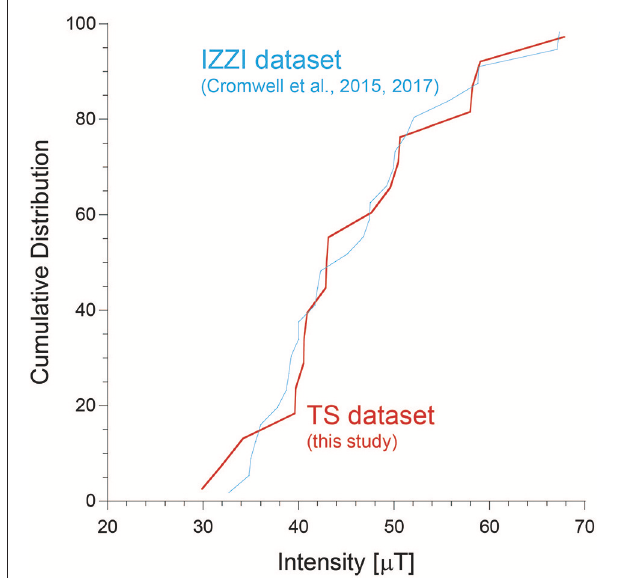
FIGURE 7 | Cumulative distribution function (CDF) curves for the TS dataset (this study, red) and the IZZI dataset ( Cromwell et al., 2015, 2017, blue). Medians are 42.9 µ T for the TS dataset ( N = 19) and 43.5 µ T for the IZZI dataset ( N = 28).